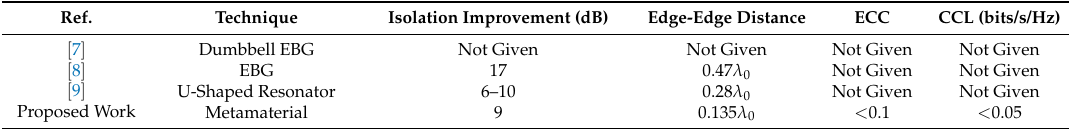
Table 3. Performance comparison with previously published